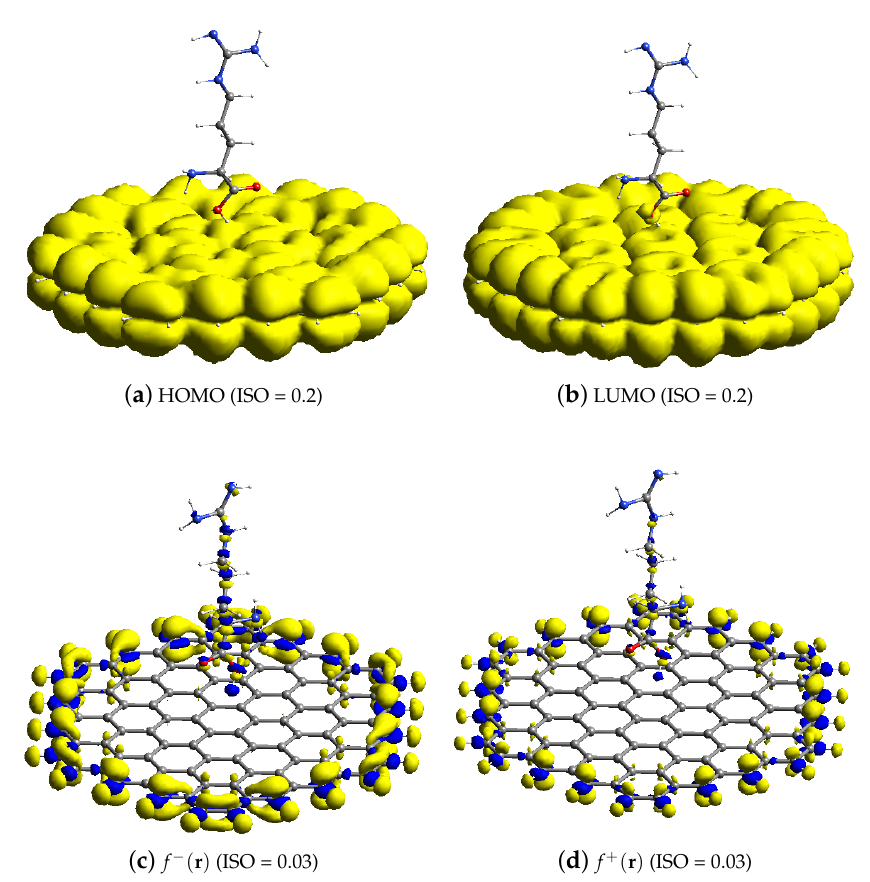
Figure 4. Average ROS FMO and Fukui analysis of